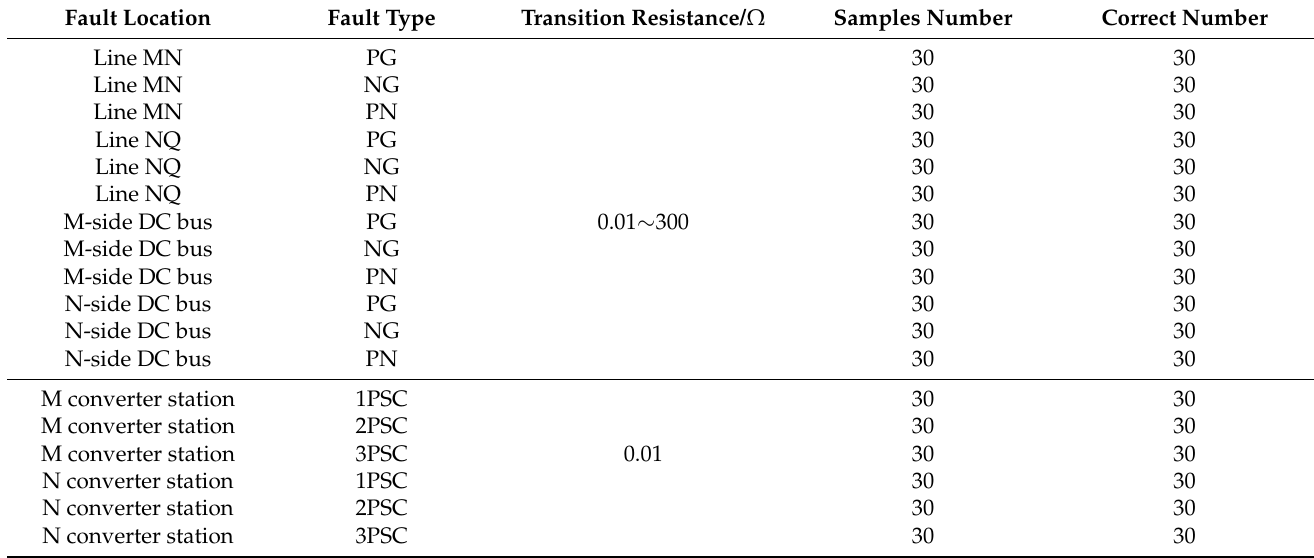
Table 7. Test results of fault classification and location during P converter station maintenance.